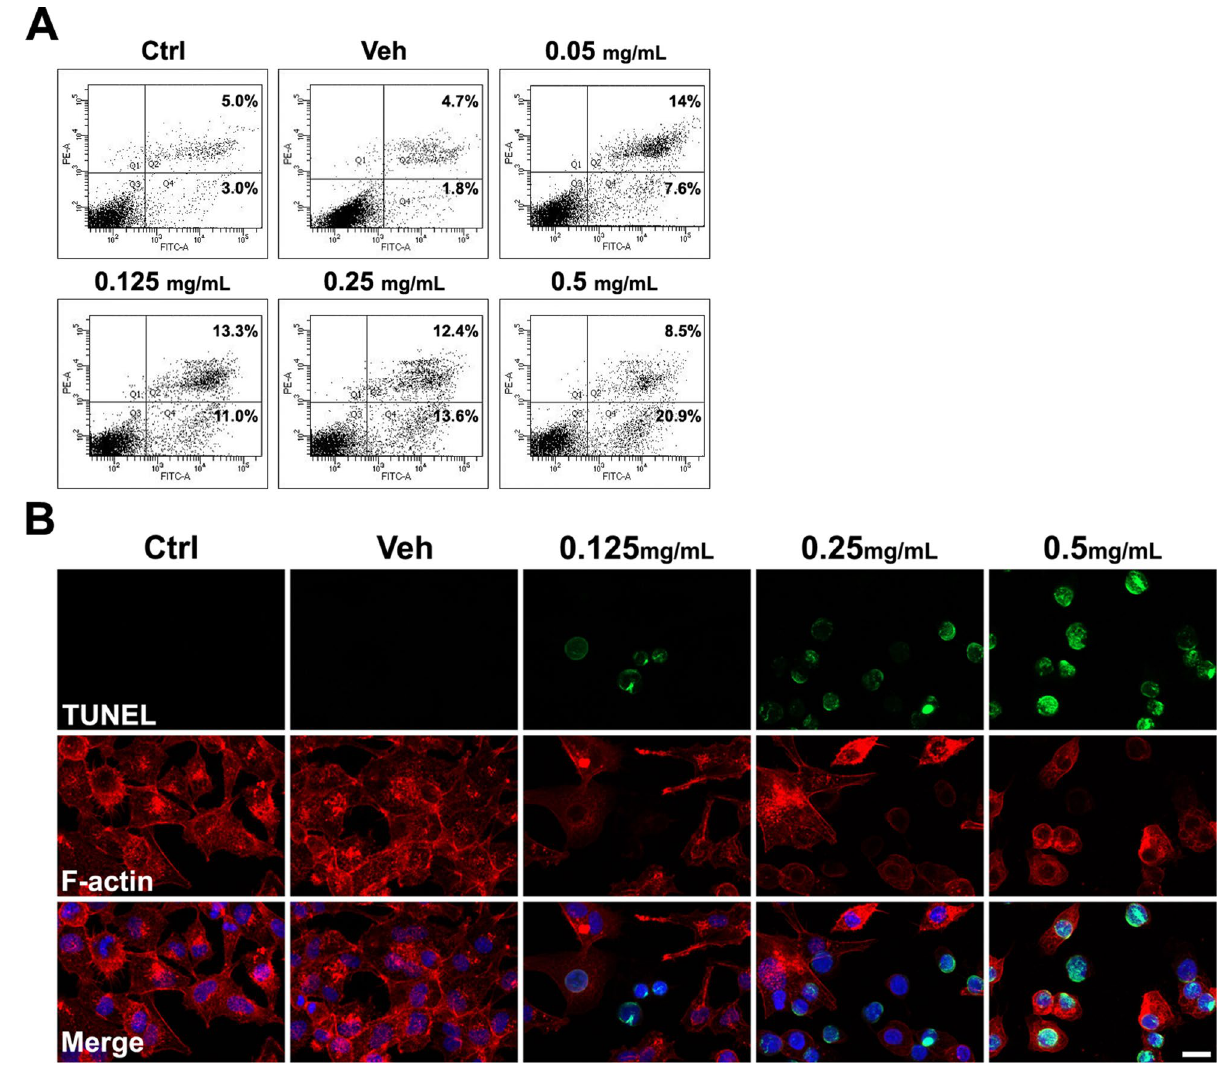
Figure 5. Apoptosis assay of HCECs after MXF exposure. ( A ) Flow cytometric analysis showed the increase of apoptosis (late) after exposure to MXF for 48 h. Staining with annexin V (FITC labeled) indicates early apoptosis, while staining with propidium iodide (PE labeled) indicates late apoptosis or necrosis with membrane damage. Cells in Q4 are only annexin V positive, meaning early apotosis. Cells in Q1 are only propidium iodide positive, meaning necrosis, and cells in Q2 are both annexin V and propidium iodide positive, meaning late apoptosis or early necrotic cells. A significant number of cells underwent both apoptosis and necrosis after exposure to MXF. ( B ) TUNEL-stained cells were significantly increased after high concentrations of MXF exposure compared with control. Ctrl: no treated normal control. Data shown are the representatives of three independent experiments. Veh: 0.5%